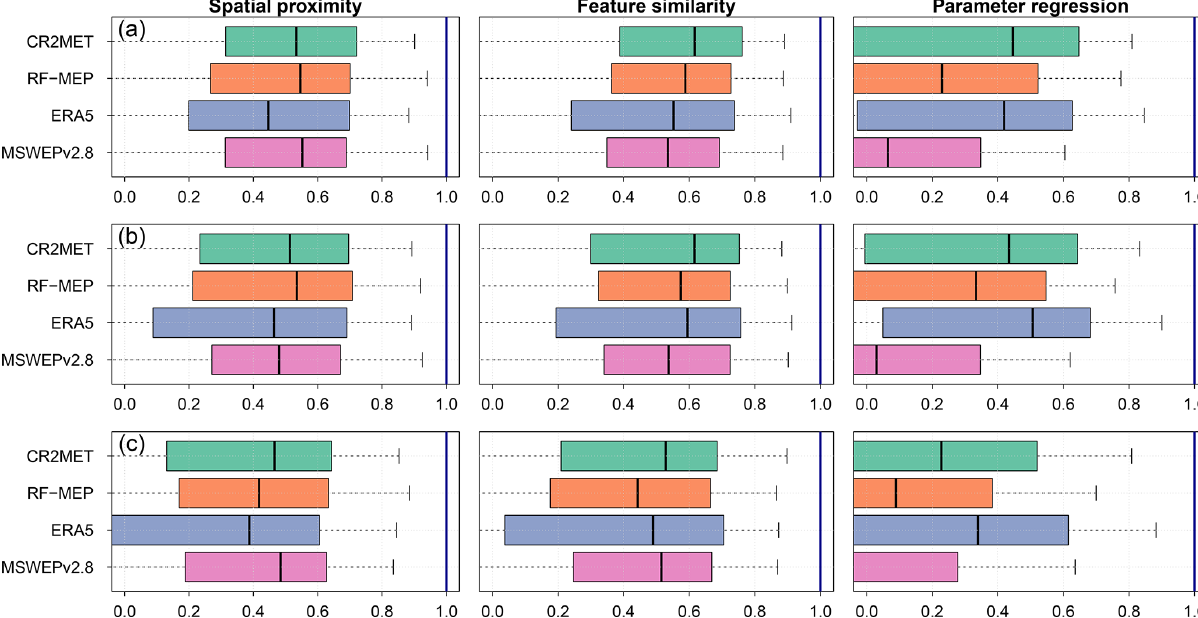
KGE (cid:48) values over the three evaluated